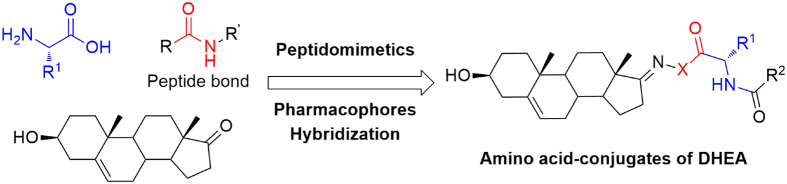
Design strategy of novel amino acid-conjugates of dehydroepiandrosterone.